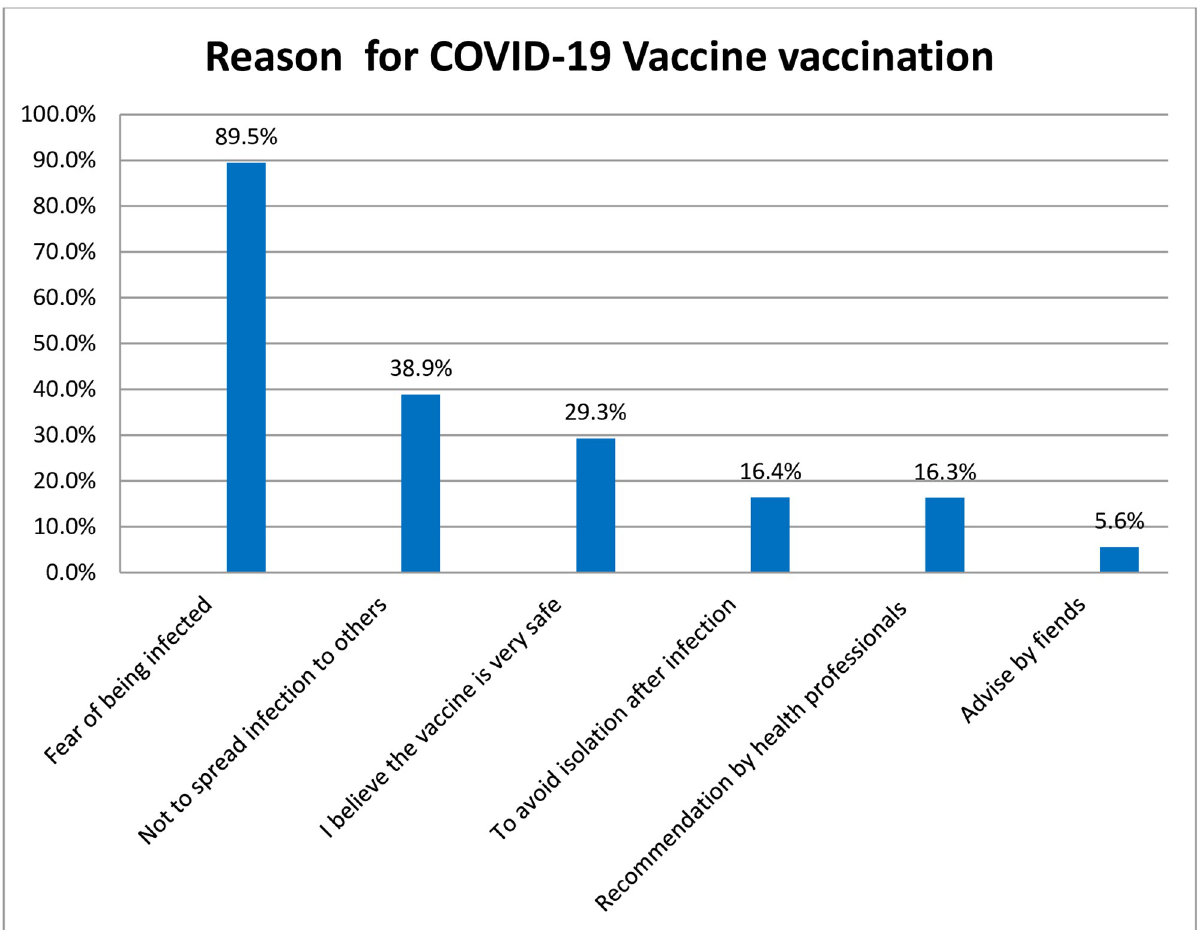
Fig 1. Reasons of COVID-19 Vaccine vaccination among participants for the study of COVID-19 vaccine complication evaluations in central Oromia region, Ethiopia, 2021.